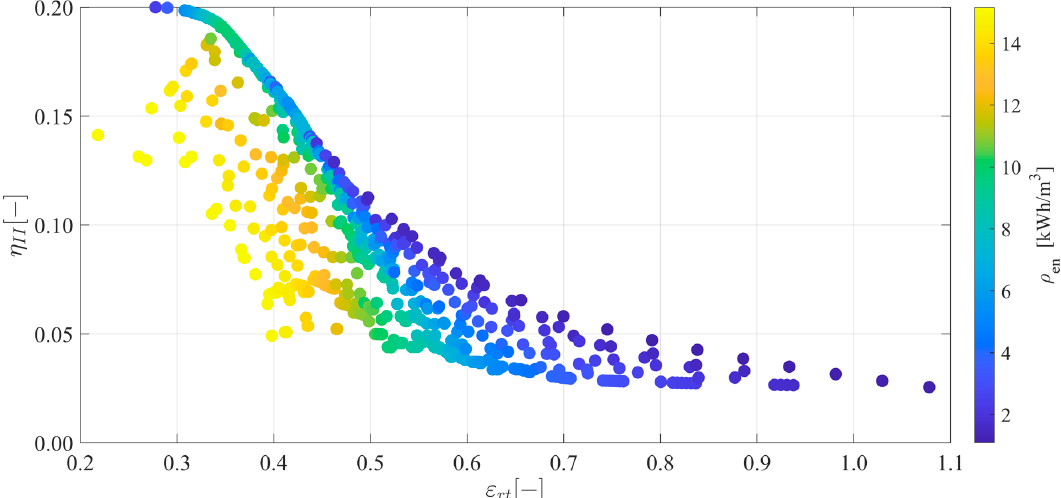
Figure 12. Optimal trade-off combinations of “hot TI-PTES” roundtrip efficiency ε rt , exergy efficiency η II and energy density ρ en in kWh/m 3 . Data from [28].